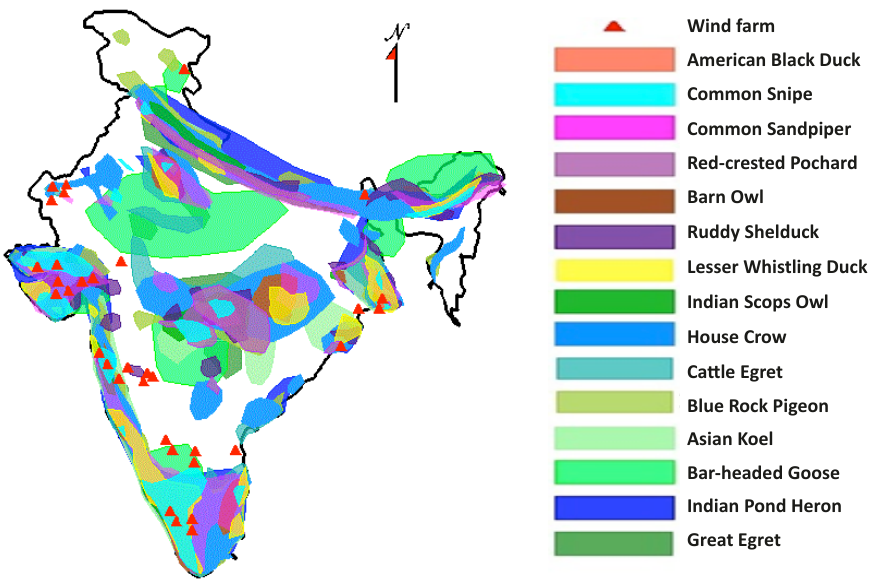
Figure 4. Remote sensing and geographical information system mapping showing the distribution mapping of fifteen bird species considered in this study